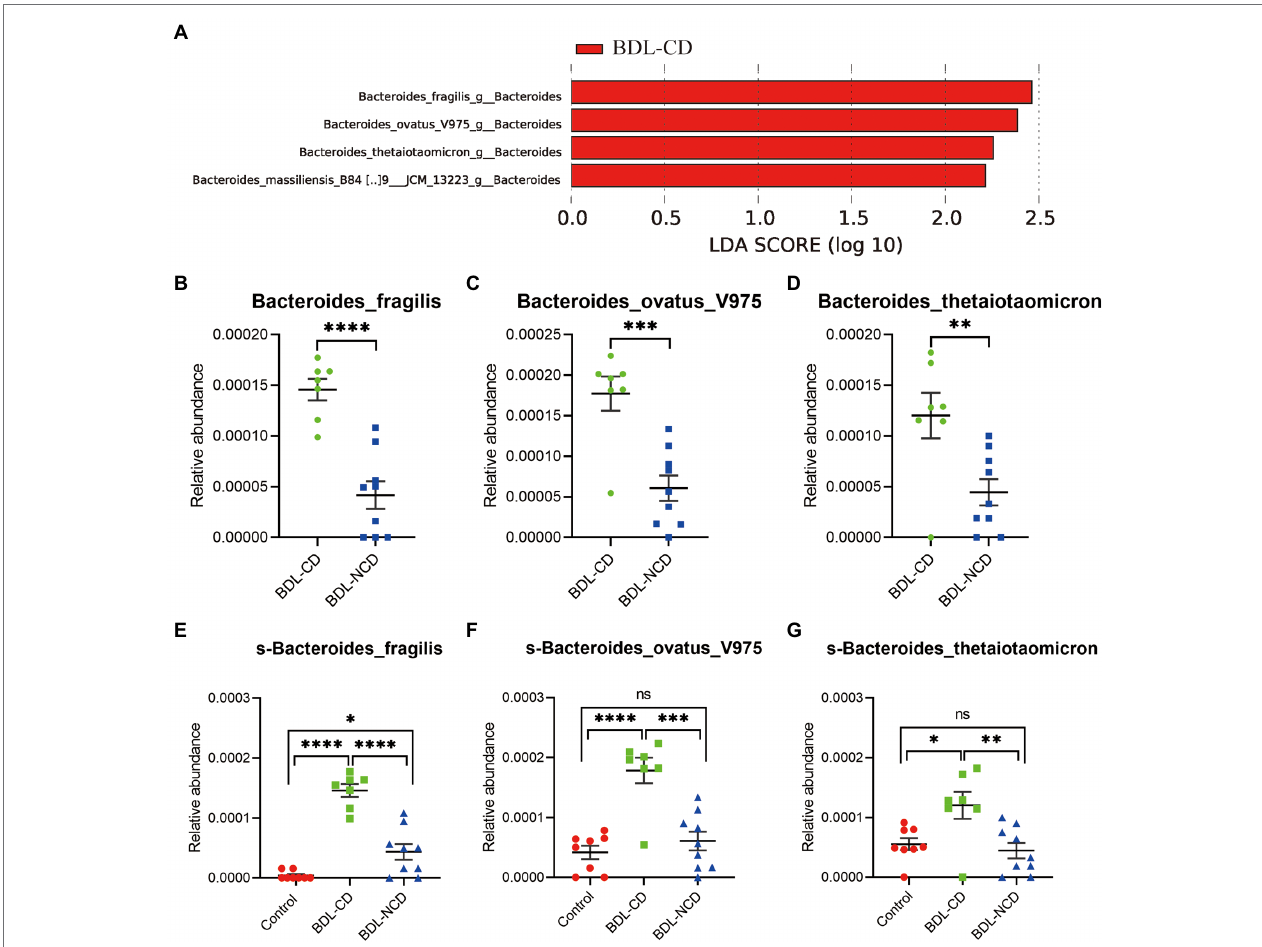
FIGURE 5 | The relationship between dysbiosis markers and cognitive dysfunction. (A) Linear discriminant analysis effect size between the BDL-CD and BDL-NCD groups. (B–G) Relative abundance of gut microbiota at the species level. Data are presented as the mean ± SEM. * p < 0.05; ** p < 0.01; *** p < 0.001; **** p < 0.0001; and ns, not